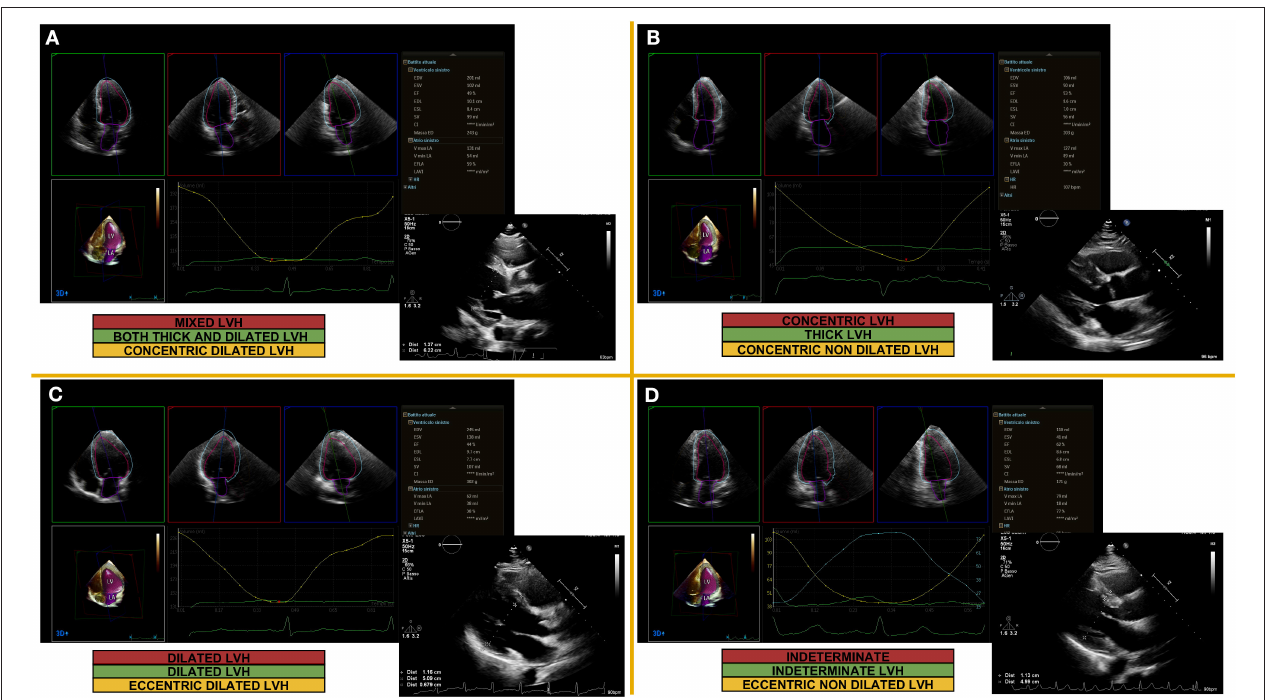
FIGURE 2 | Examples of echocardiographic left lentricular hypertrophy classification based on concentricity, mass and volume quantification. Parasternal long axis view for linear 2D measurements (LV mass, concentricity) and 3D measurements (LV volumes) obtained from automated DHM (Dynamic Heart Model, Philips Healthcare, Andover, MA, USA) in a patient with mixed LVH (A) , concentric LVH (B) , dilated LVH (C) , indeterminate LVH (D) ; 2D, two-dimensional; 3D, three-dimensional; LV, left ventricular; LVH, left ventricular hypertrophy.